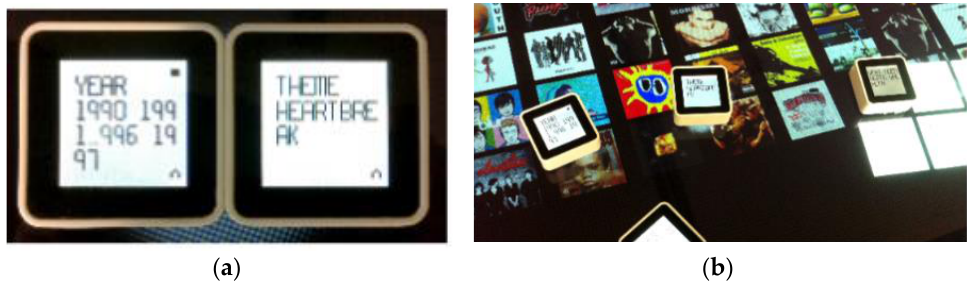
Figure 28. Creation of database Query with Sifteo Cubes ( a ), representation of the results of a query ( b ) [49].